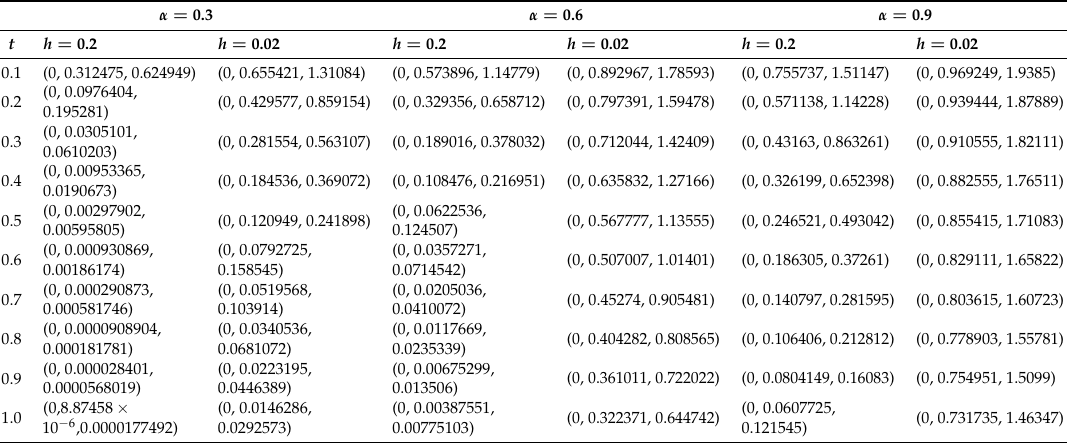
Figure 2. ( a ) The exact solution ( b ) the Caputo gH-derivative of solution defined in Example 2 for α = 0.3. Table 2. Numerical results of Example 2 for various t , α and h . α = 0.3 α = 0.6 α =